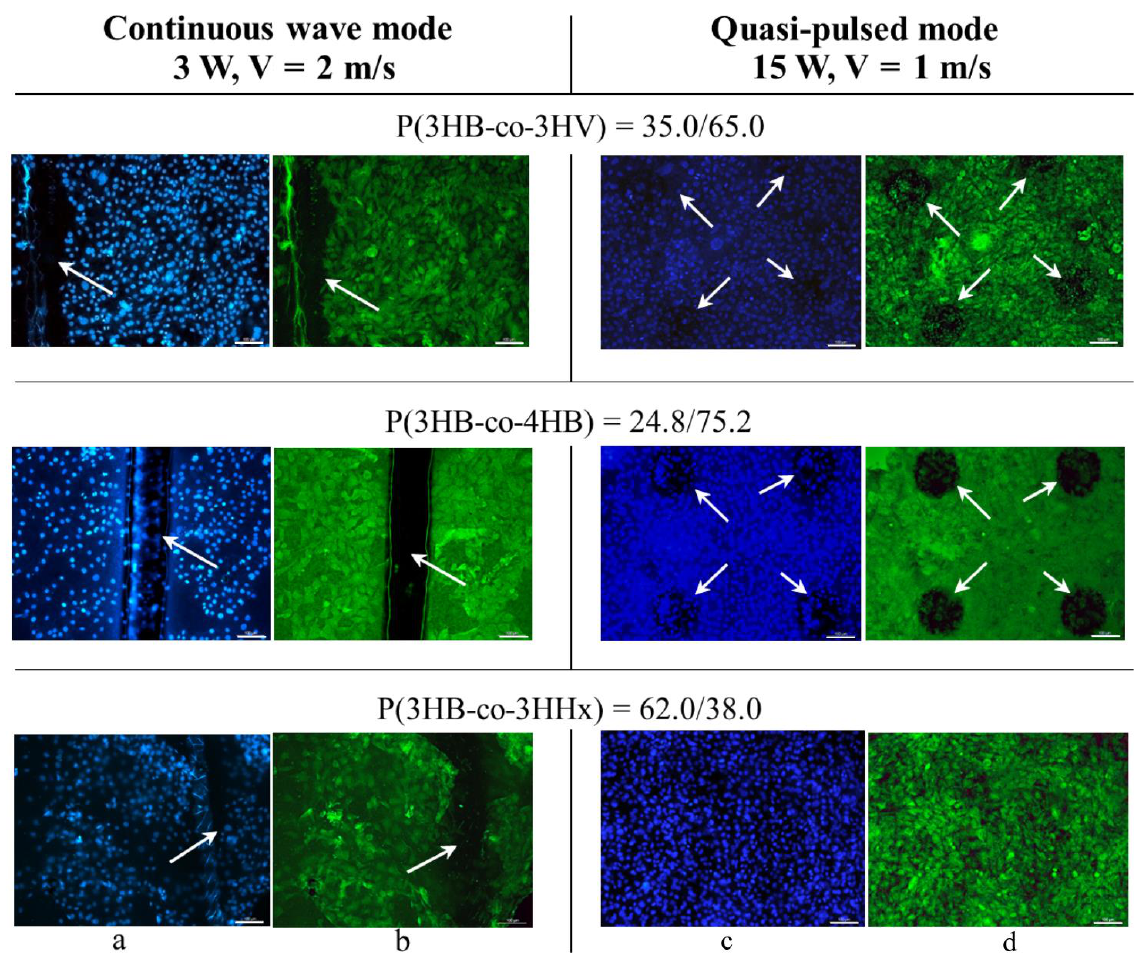
Figure 6. Photo of NIH 3T3 mouse fibroblasts stained with DAPI ( a and c ) and FITC ( b and d ) on PHAs polymer films of various compositions treated with continuous and quasi-pulse laser irradiation, bar = 100 µm.